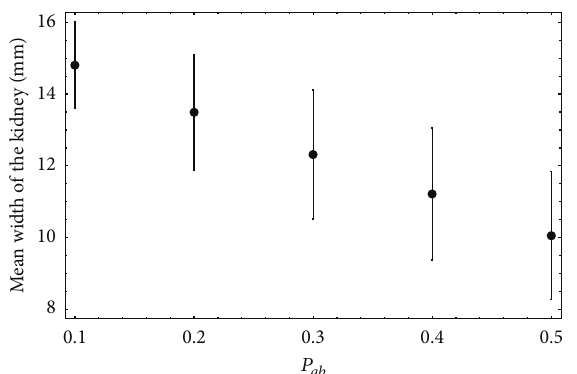
Figure 1: The mean ± SD of width of 5000 trees generated for 5 different probabilities of 𝑎 𝑏 and 𝑎 𝑝 .